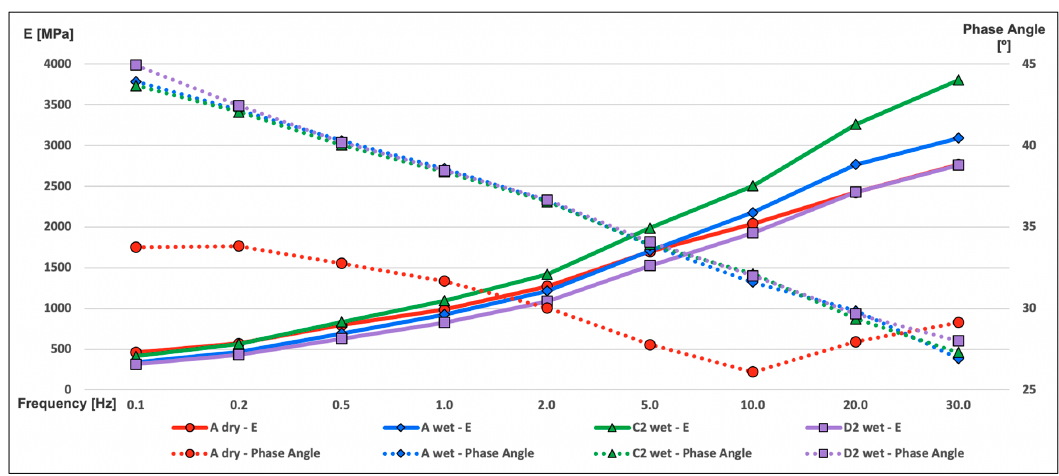
Figure 4. Dynamic modulus test. Table 3. Goodness-of-fit statistic. Dynamic modulus.